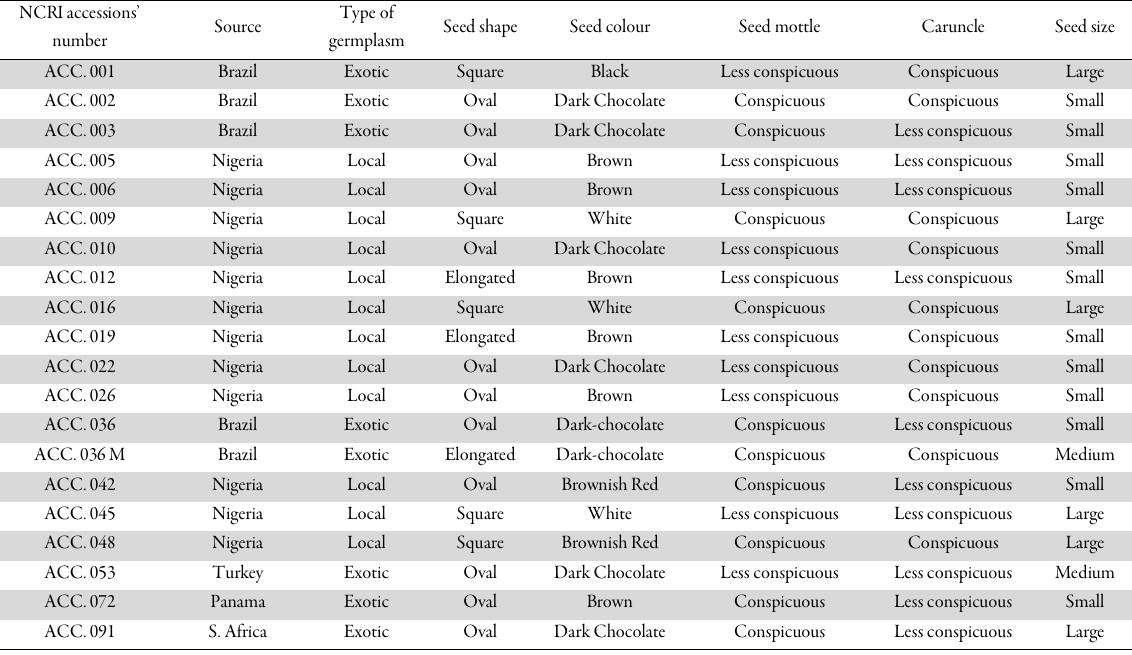
Table 2. Seed physical characteristics of 20 promising castor genotypes at NCRI Badeggi, Nigeria